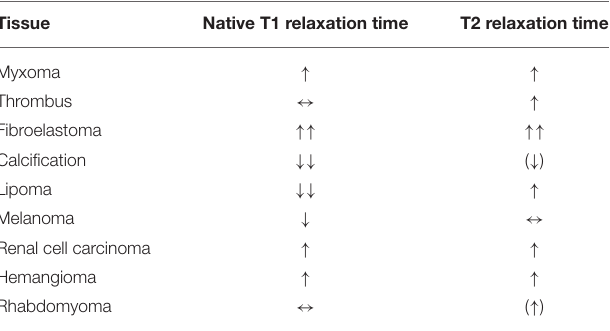
TABLE 8 | Relaxation times in cardiac masses compared to myocardium.